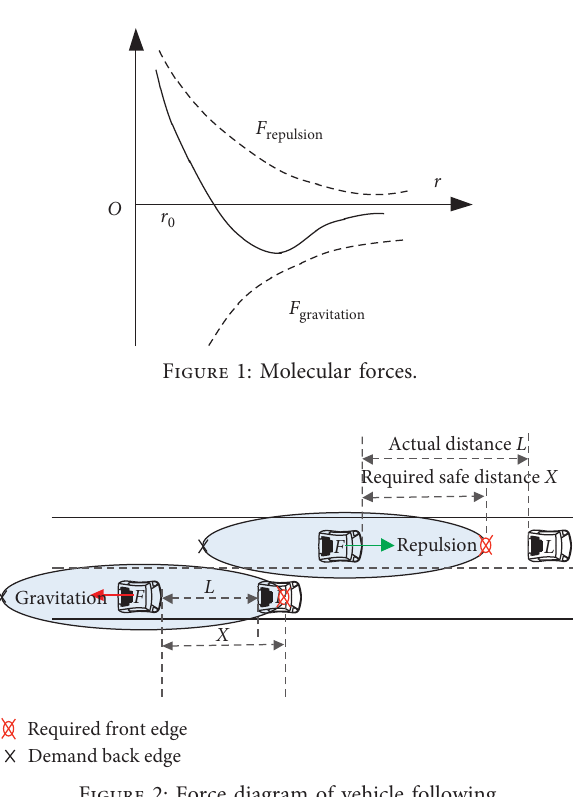
Figure 2: Force diagram of vehicle